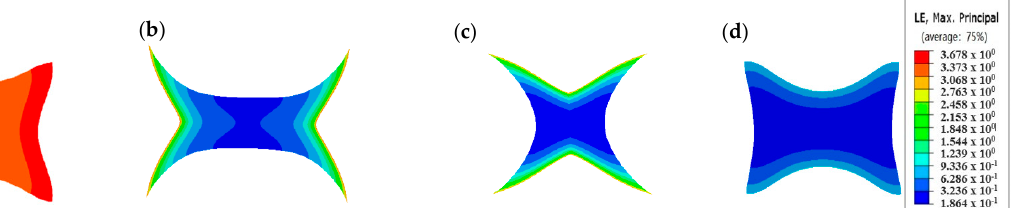
Figure 18. Cross sections of each rib after stretching of performance optimization multi-axial geogrid. ( a ) 90° main rib, ( b ) 90° sub-rib, ( c ) 0° rib, ( d ) 30° rib.